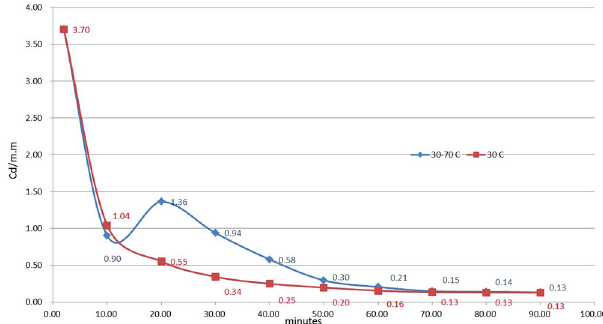
Figure 5. TL-time plot for tests performed with a temperature increase during afterglow. The square symbol curve is the afterglow curve for a film at a constant 30 °C throughout the lifetime. For the diamond symbol curve, the temperature was increased to 70 °C 10 minutes after excitation was terminated.